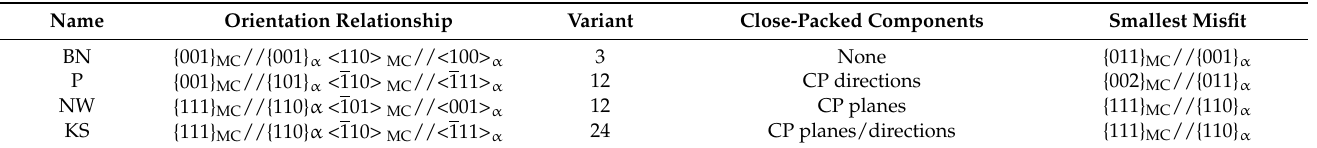
Table 1. Summary of the known orientation relationship between second phases and ferrite